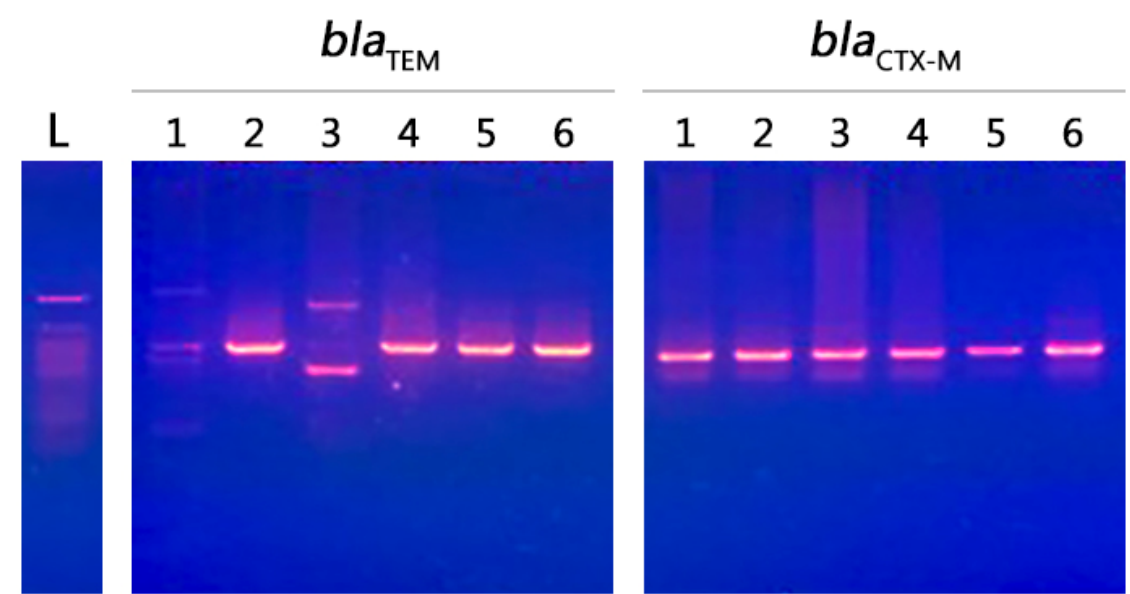
Figure 6. The presence of bla CTX-M and bla TEM genes. bla CTX-M genes in multidrug-resistant isolates obtained from three different countries are shown. The DNA ladder is 50 bp and the bla TEM gene (size 600 bp) was found in most of the selected isolates ( n = 4); it was not detected in E. coli and K. pneumoniae strains obtained from Saudi Arabia and Egypt, respectively. The bla CTX-M gene (size 500 bp) was found in all selected isolates ( n = 6). The bla CTX-M gene was detected in E. coli and K. pneumoniae obtained from the three countries included in this study; 1, 2, and 5 are codes for the selected E coli strains from Saudi Arabia, Egypt, and Sudan, respectively; 3, 4, and 6 are codes for the selected K. pneumoniae strains from Egypt, Saudi Arabia, and Sudan, respectively.